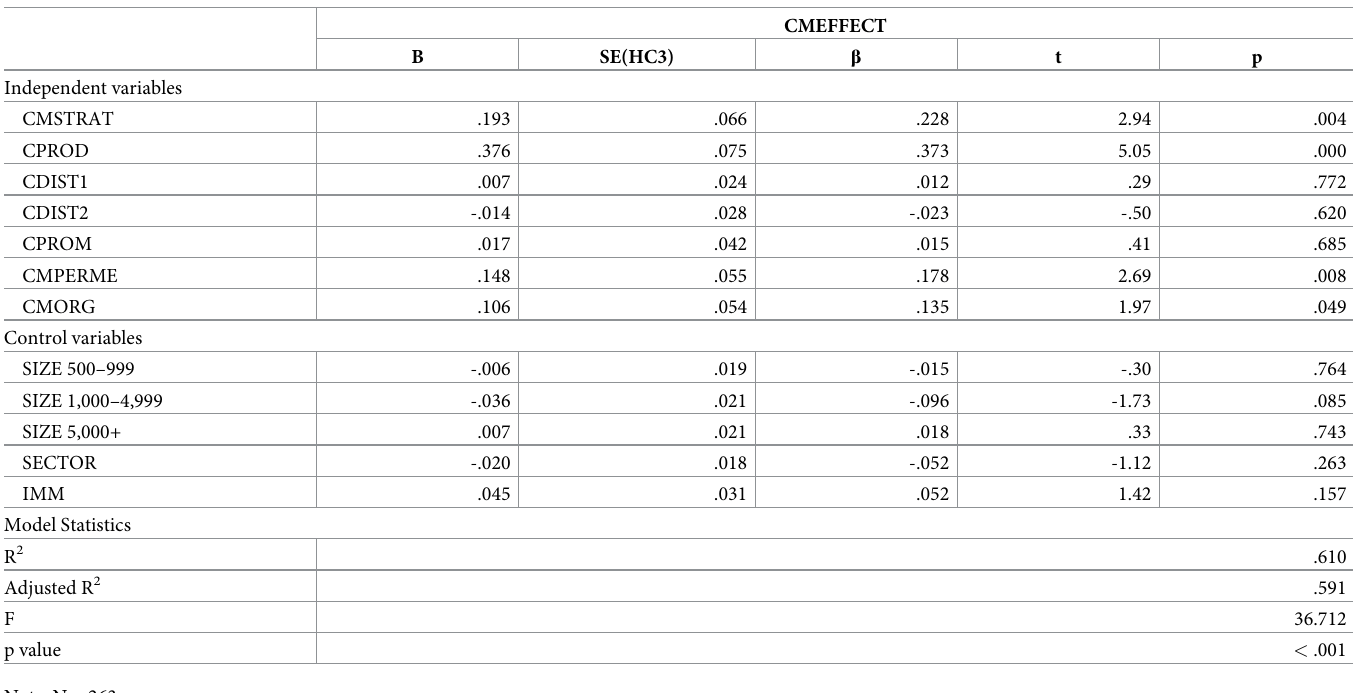
Table 2. Determinants of content marketing